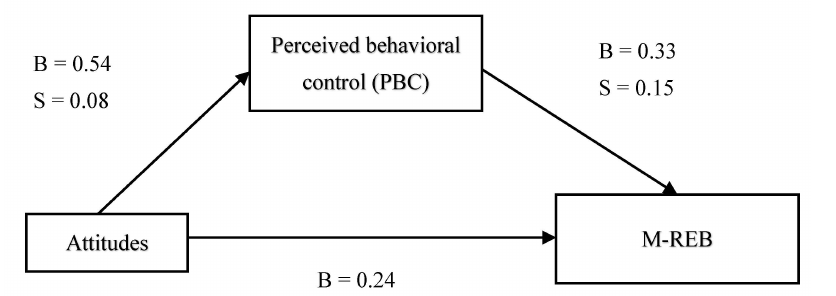
Figure 1. The mediation effect of perceived behavioral control in marine environmental attitude- behavior